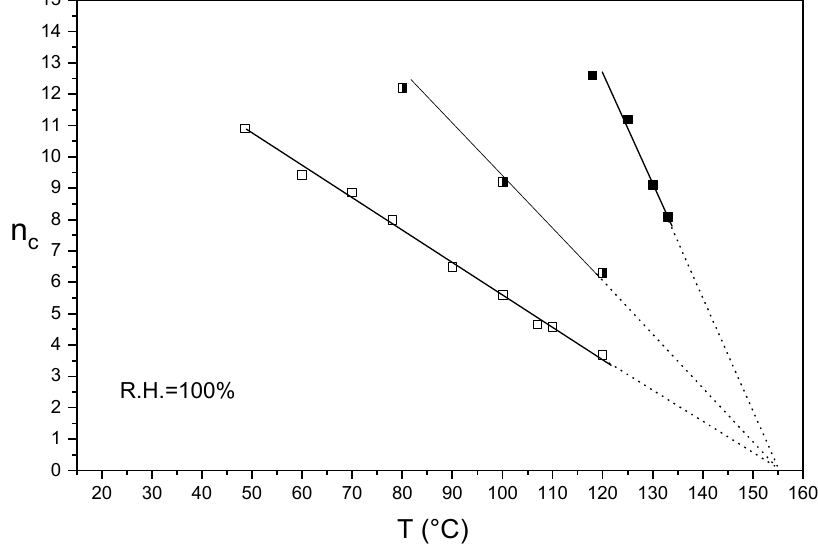
Figure 2. n c / T plot of semi-crystalline Aquivion ® 870 before ( empty squares ) and after annealing at 140 °C in presence of DMSO for 3 ( half empty squares ) and 7 days ( full squares ).